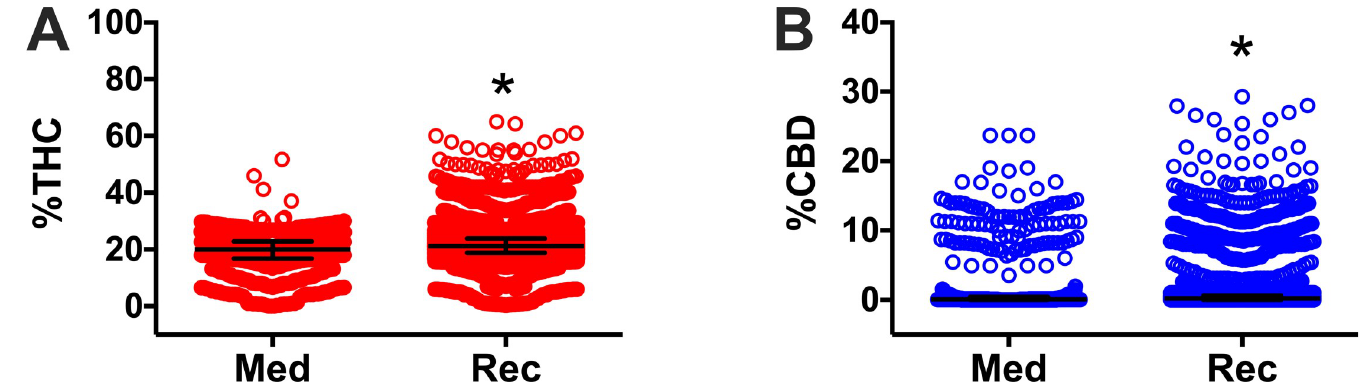
Fig 1. Percent THC (A) and percent CBD (B) in legalized medicinal or recreational dispensaries in the Northeastern and Western regions of the United States. Herb cannabis products offered in dispensaries from states with medicinal only (Med; ME, MA, NH, RI, VT, and NM) and recreational and medicinal (Rec; CA, CO, and CA) programs were included for analysis and represented individually as circles. Data are presented as mean ± SD. � P < 0.05 vs. medicinal, by Welch’s t test. The outlier products in the graph might represent herbal products infused with concentrated THC or CBD extracts, however we did not observe such a claim in the studied websites where these products were